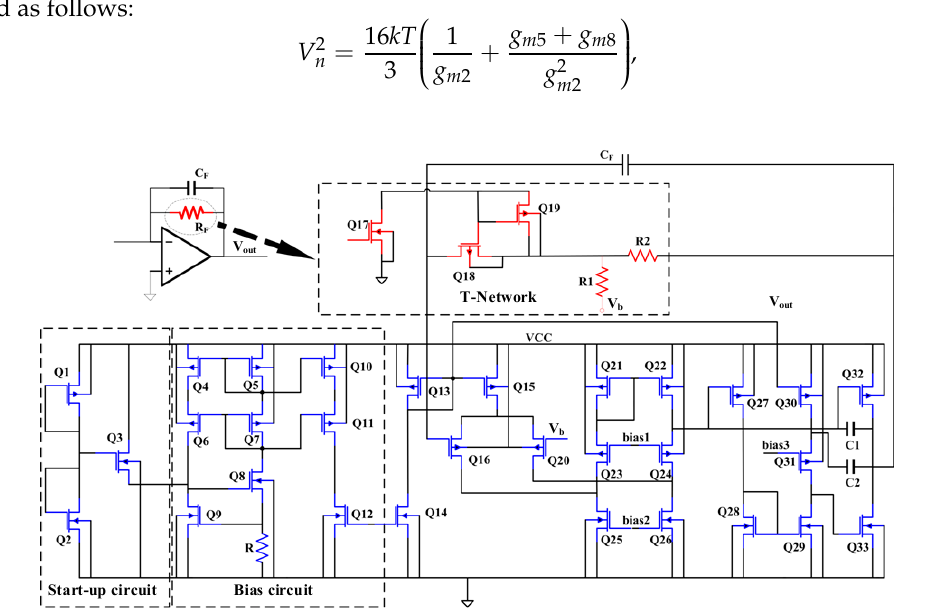
Figure 8. Transimpedance structure of charge voltage conversion circuit